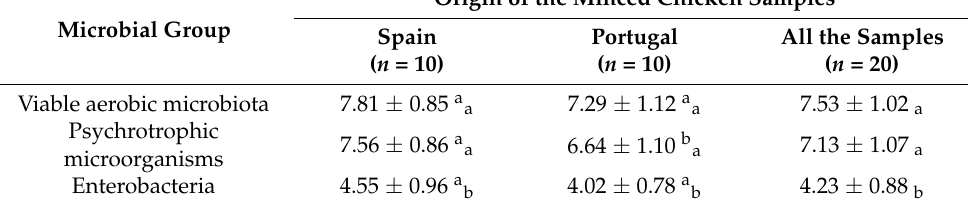
Table 1. Microbial counts (log 10 cfu/g) recorded in samples of minced chicken from Spain and Portugal. Microbial Group